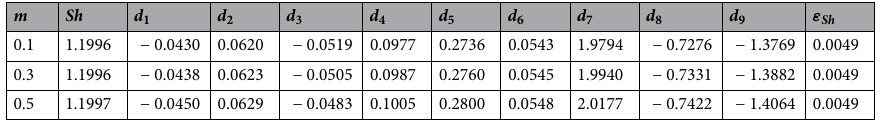
Table 8. Numerical computations for quadratic regression coefficients and error bound for estimated Sh x Re − 1 / 2 x